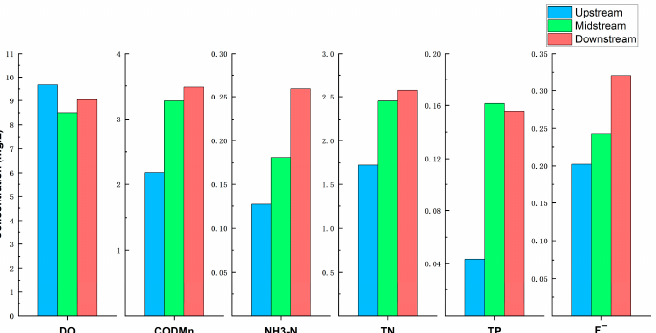
Figure 3. Average concentration of water quality in the upstream, midstream, and downstream in the Xinjian River. When the average concentrations of TN and TP in the Xinjian River and in Lishui City with 100 sites during the study period were compared, the former is evidently inferior to that of the latter (Figure 4). The TP in the upstream is comparable to that of Lishui’s average condition, which is significantly lower than that in the midstream and downstream.